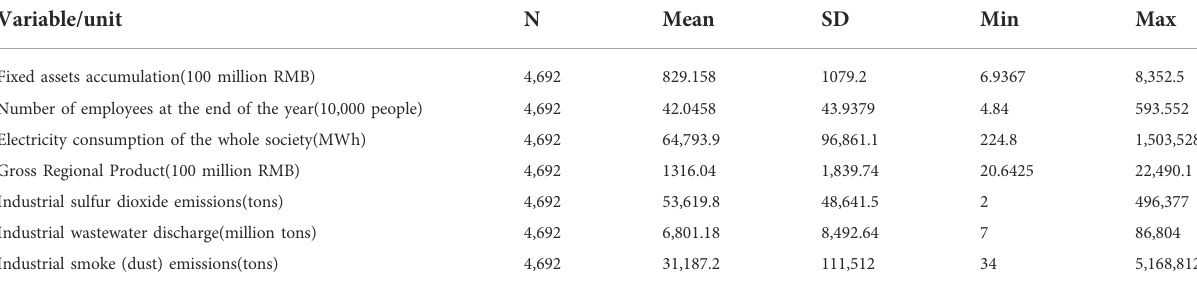
TABLE 2 The descriptive statistics of input and output indexes.